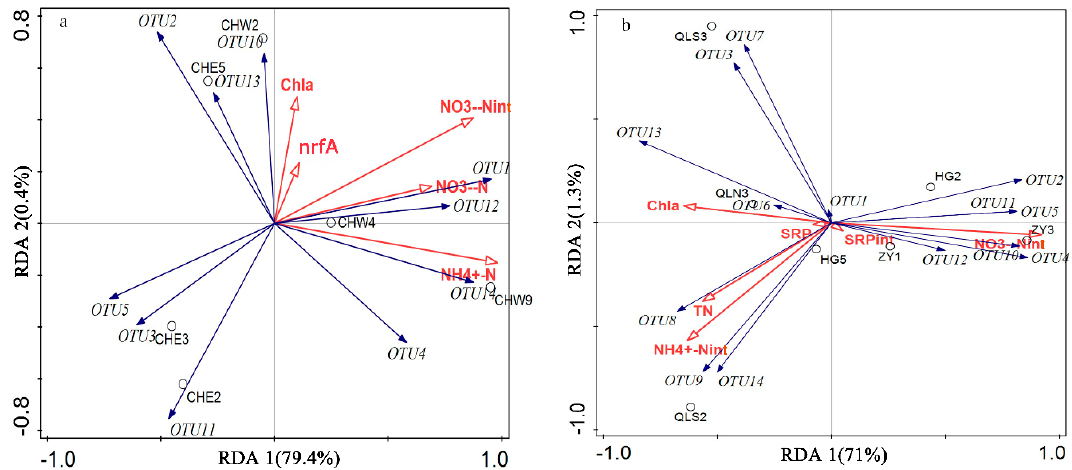
Figure 6. Redundancy analysis (RDA) deciphering the relationship between operational taxonomic units (OTUs) and environmental variables in Lake Chaohu ( a ), Lake Qingling, Lake Houguan, and Lake Zhiyin ( b ). Red arrows indicate the environmental factors, and blue arrows indicate the OTUs. Circles represent the sampling sites.